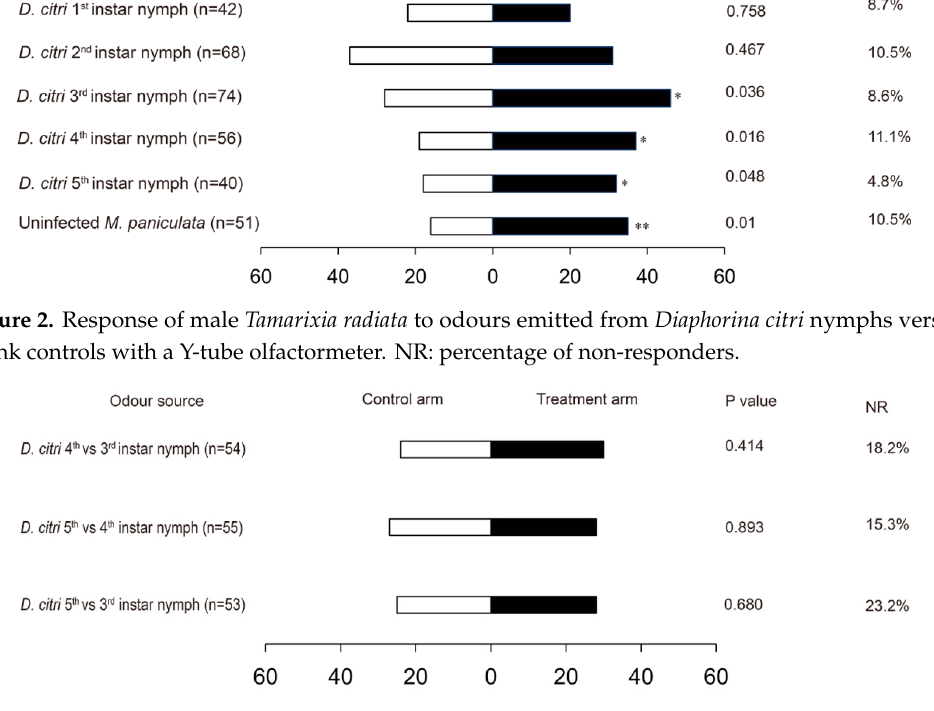
Figure 3. Response of female Tamarixia radiata to odours emitted from Diaphorina citri 5th vs. 3rd, 5th vs. 4th, and 4th vs. 3rd instar nymphs with a Y-tube olfactormeter. NR: percentage of non-responders. Figure 2. Response of male Tamarixia radiata to odours emitted from Diaphorina citri nymphs versus blank controls with a Y-tube olfactormeter. NR: percentage of non-responders.